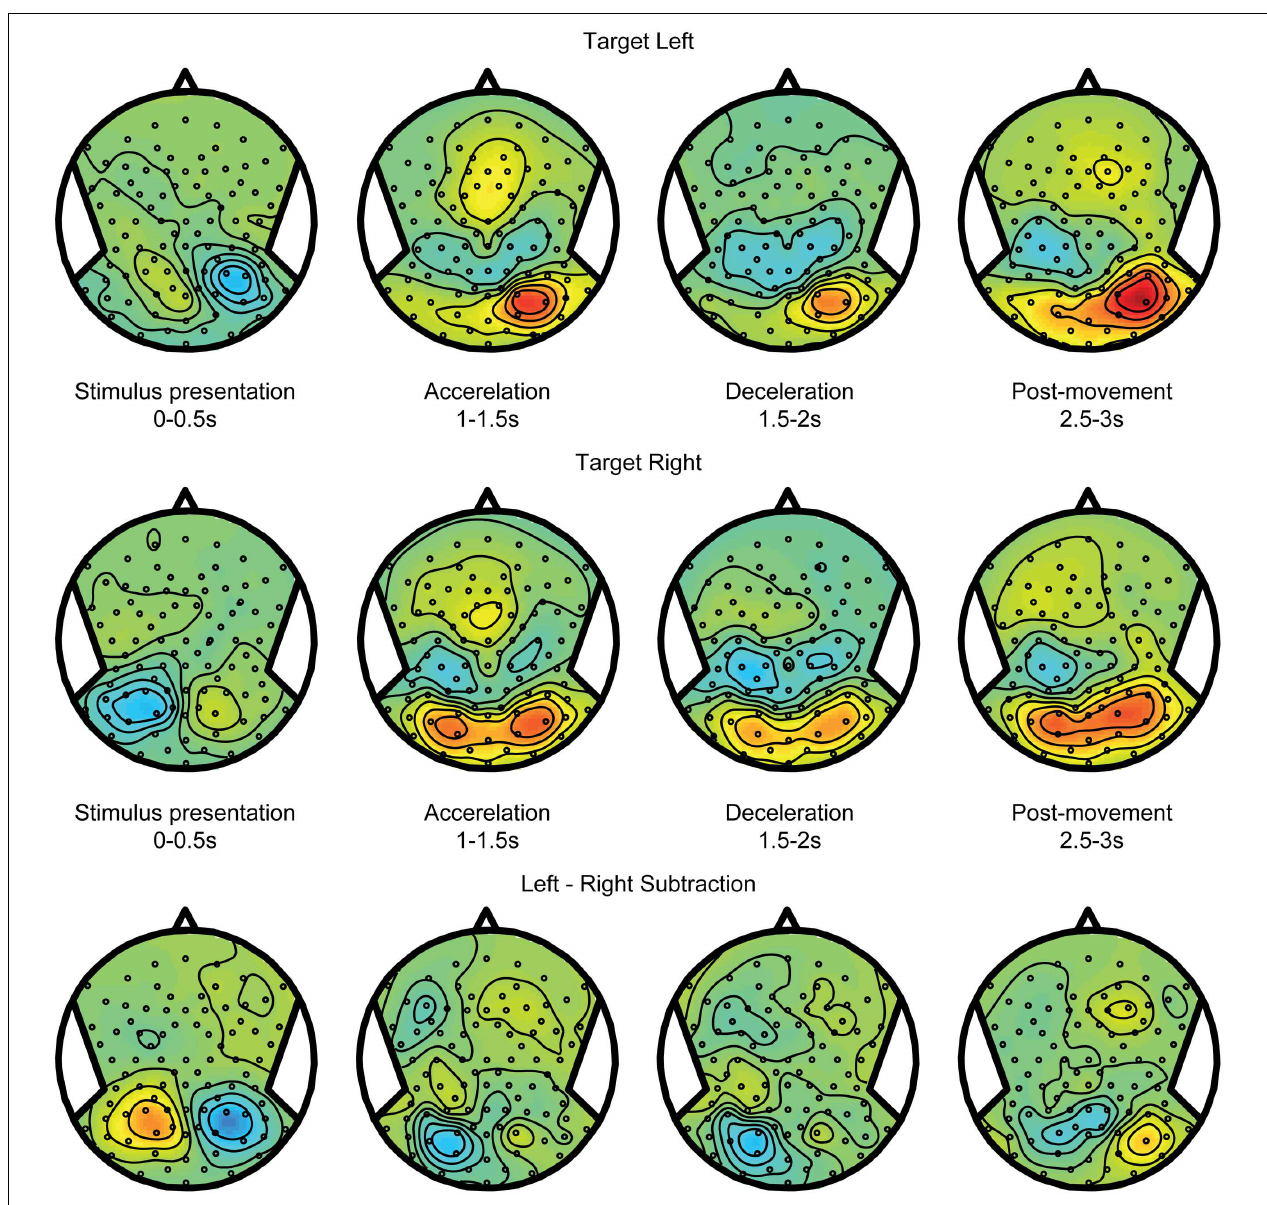
FIGURE 5 | Spatial updating within hemifields. EEG topoplots from the world-fixed condition, averaged over trials where subjects indicate that the target remains on the same side as the initial target on the left (Top) and right (Middle) . Visually presented targets are initially reflected by contralateralized alpha reductions, and evolve into alpha increases contralateral to the remembered target after motion. (Bottom) Subtraction of left and right target conditions, isolating activity related the target